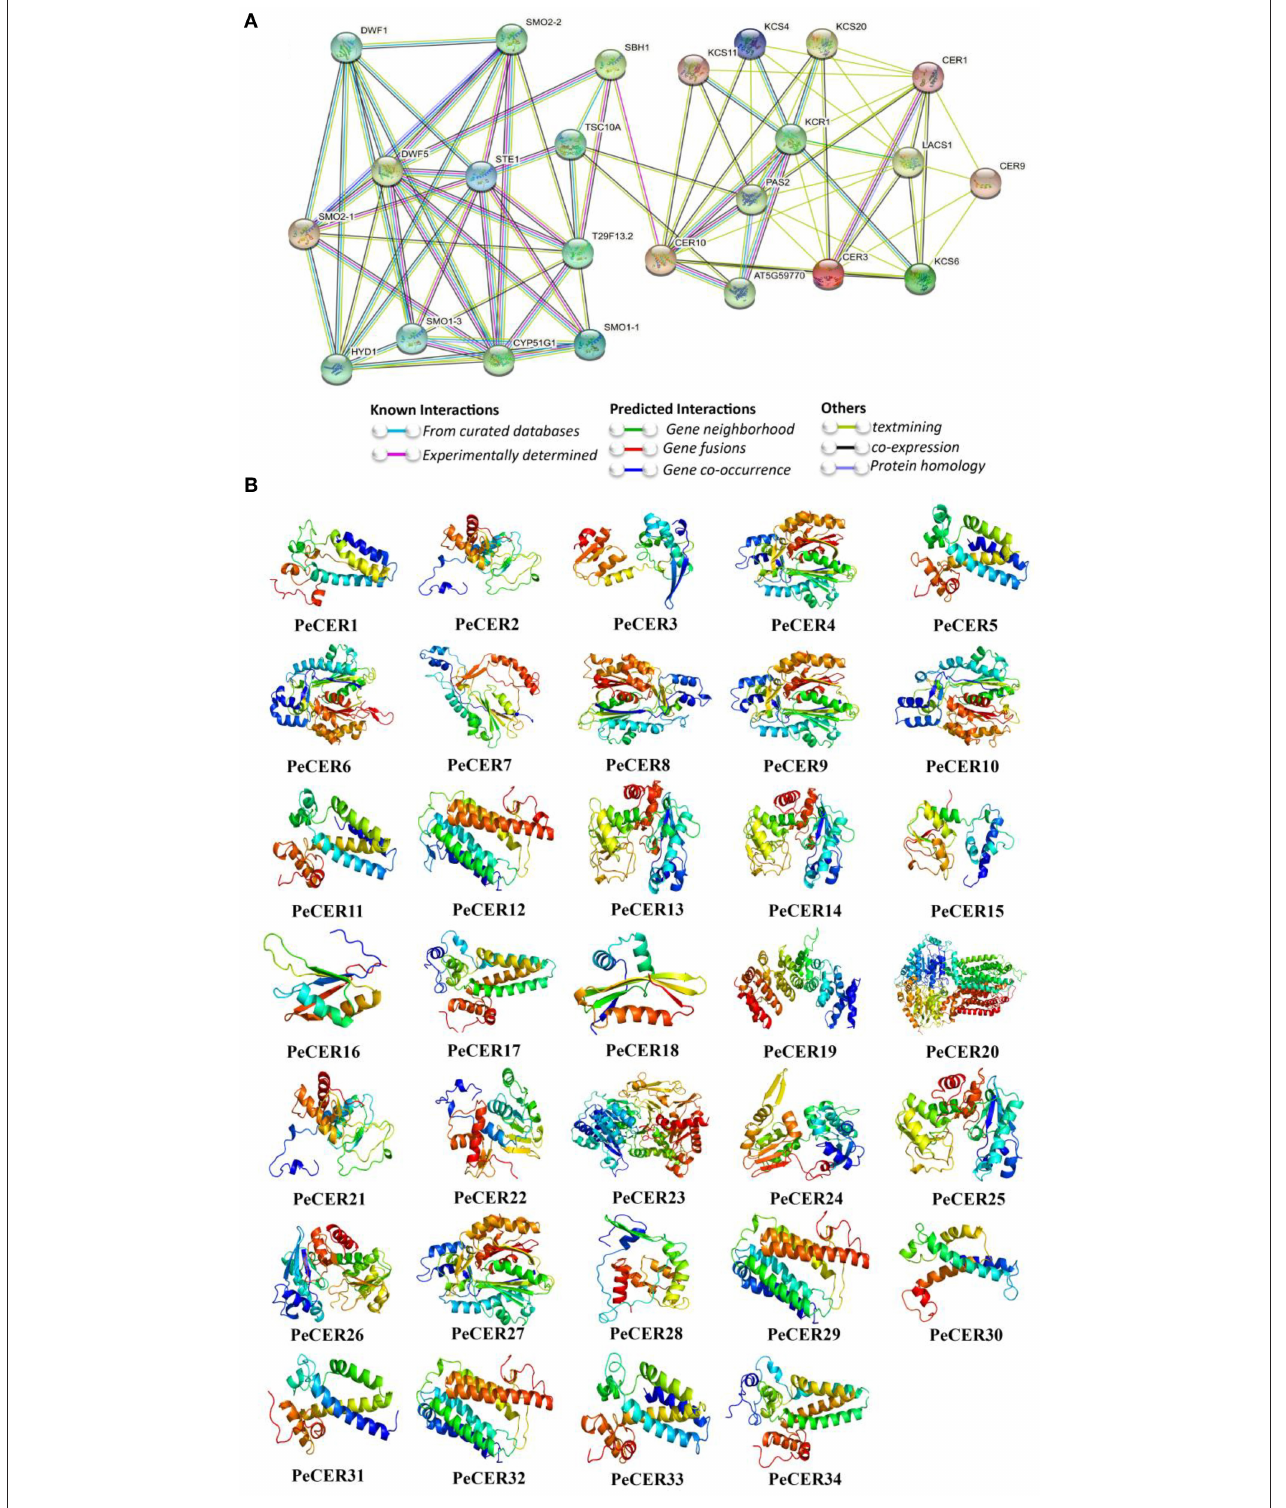
FIGURE 5 | Protein-protein interaction of PeCER proteins based on known Arabidopsis protein orthologous. (A) The network was constructed using the online STRING software. The proteins were displayed at network nodes with 3D structure of the proteins in nodes, and the line colors indicate different data sources. (B) Predicted 3D models of PeCER proteins. 3D models were constructed using the online Phyre2 server with default mode.